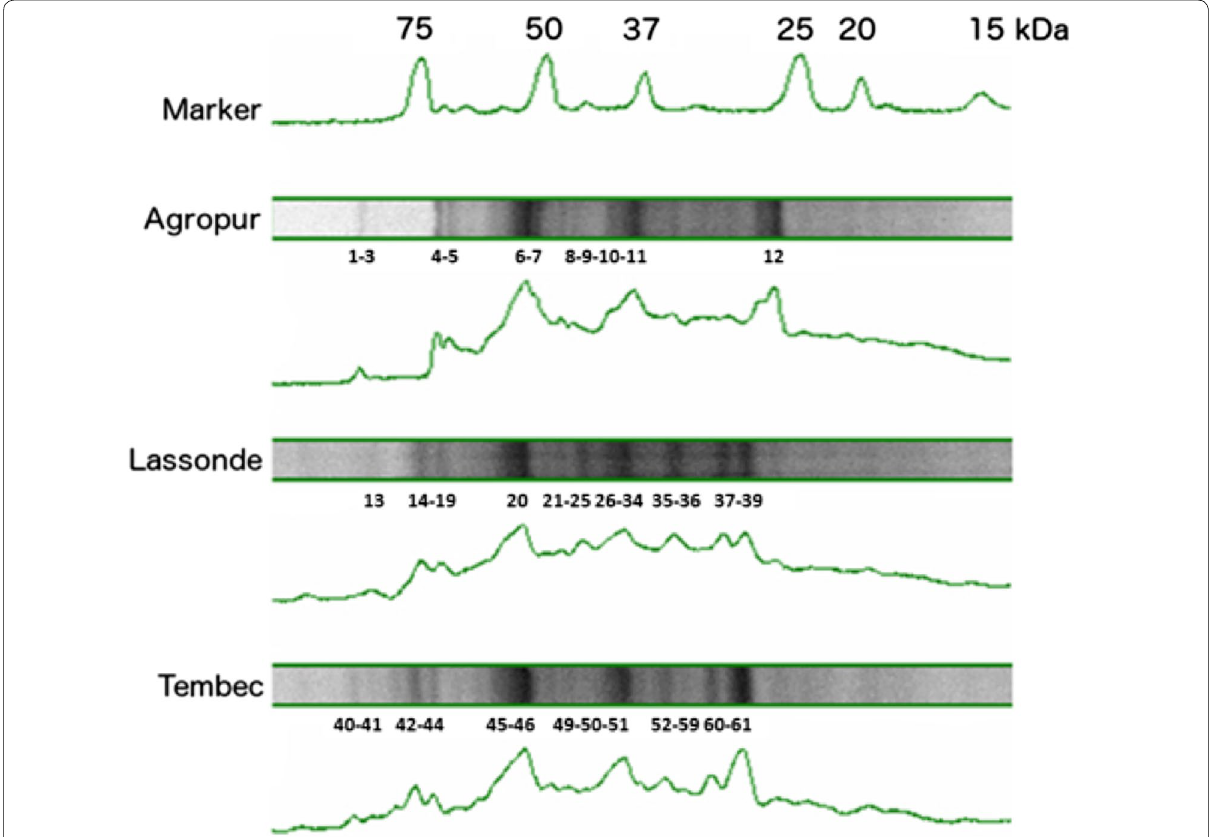
Fig. 1 Electrophoresis of precipitated proteins from Agropur, Lassonde and Tembec sludges. Migration is from left to